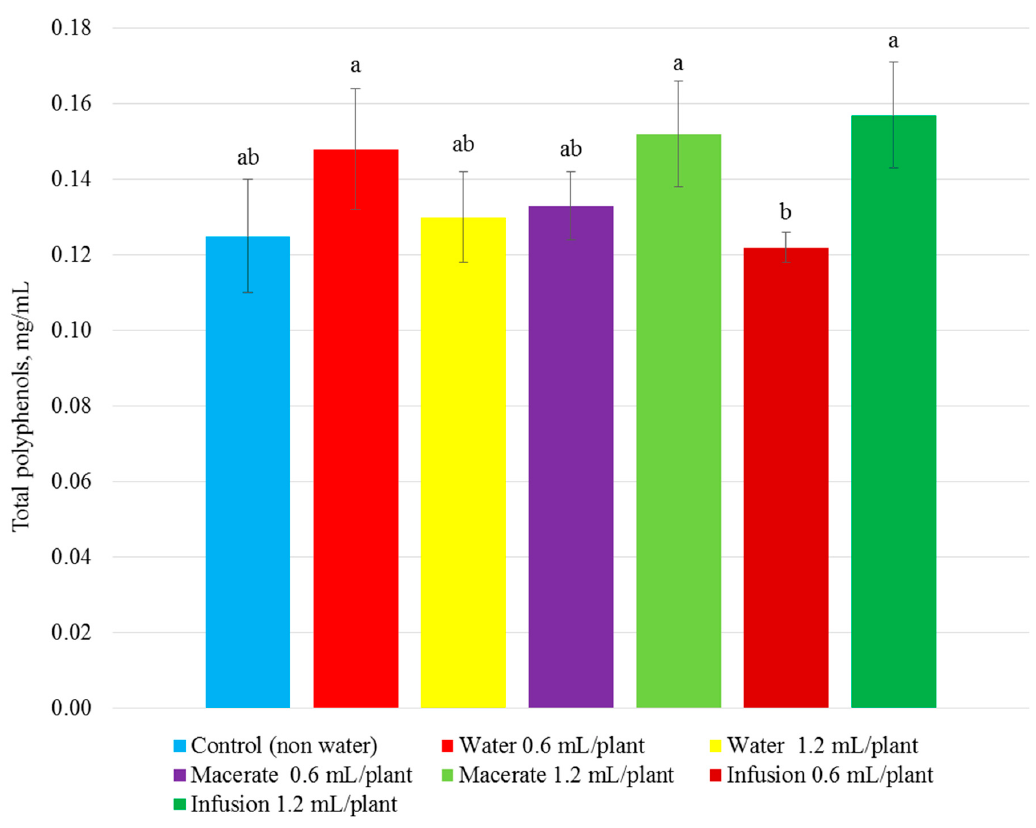
Figure 4. Total concentration of polyphenols in potato leaves treated with extracts form Artemisia vulgaris L. (average of three independent experiments and SD). Values followed by different small letters are significantly different at p < 0.05.